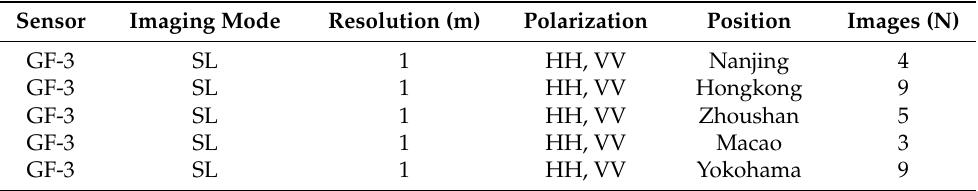
Table 1. Detailed information of the original SAR images.